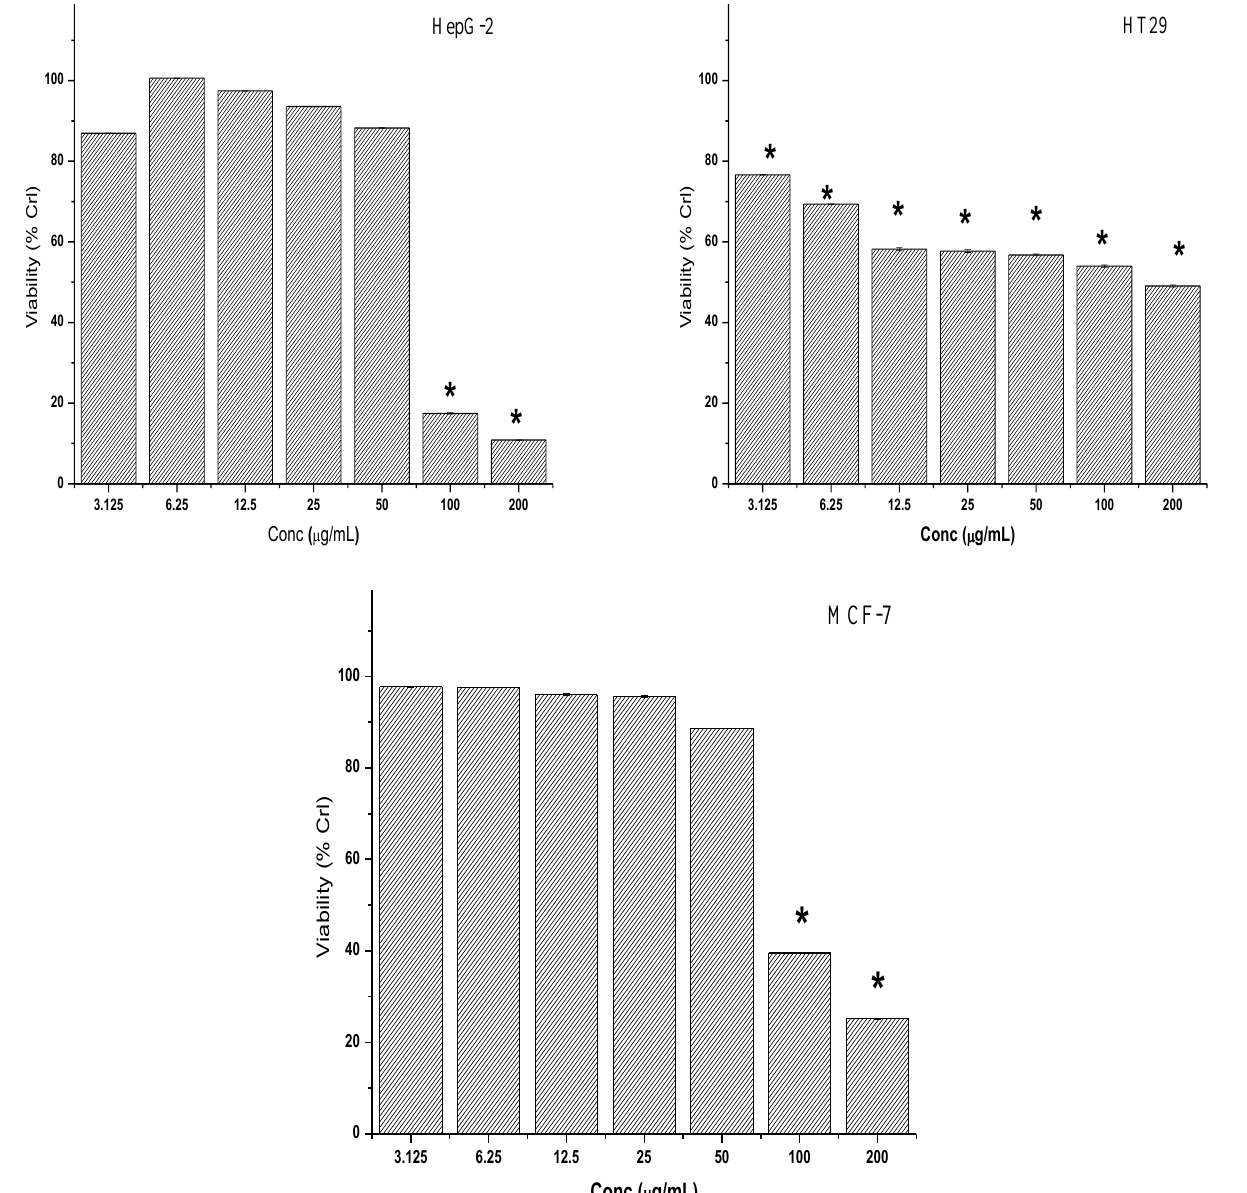
Figure 7. Cytotoxicity effect of the methanol extract on HepG2, HT-29 and MCF-7 cancer cell lines. Cells were exposed to increasing concentrations of the crude extracts for 72 h. The results of the three independent tests are shown as the mean ± SD. * Asterisk indicates significant difference at p < 0.005. The half maximum inhibitory concentrations (IC 50 ) were measured for all the tested extracts against each of the different cell lines and the IC 50 values calculated. The IC 50 values of petroleum ether extract were found to be low for all tested cell lines when compared to those of the chloroform and methanol extracts (Table 3).